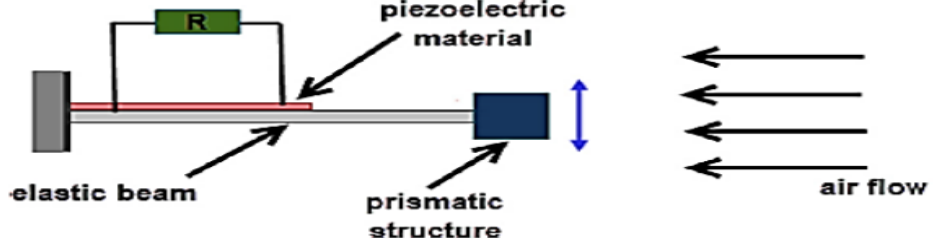
Figure 8. Example of PEH-based Galloping [134].